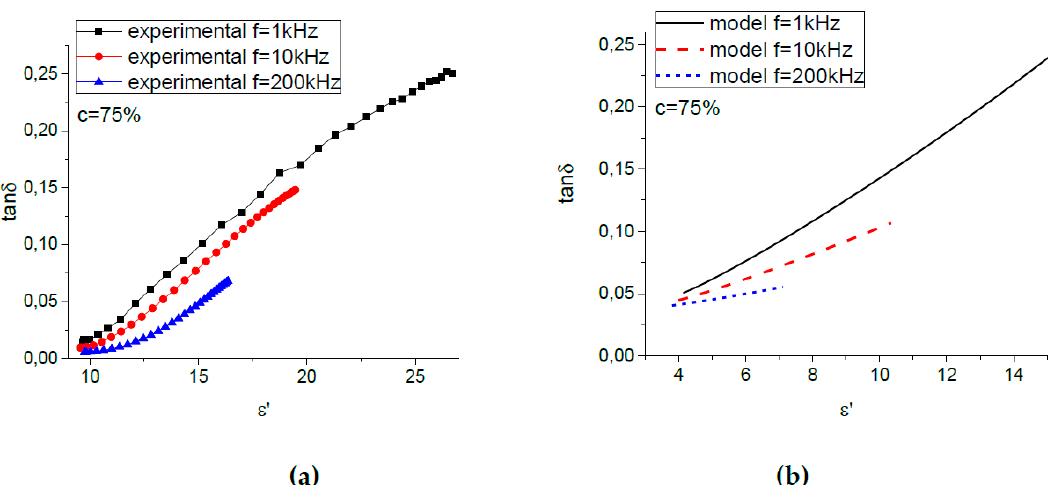
Figure 6. ( a ) Experimental and ( b ) model dependence of the dielectric loss tan δ on the relative Figure 6. (a) Experimental and (b) model dependence of the dielectric loss tan δ on the relative permittivity ε (cid:48) for MAE75 at various measurement permittivity ε ´ for MAE75 at various measurement frequencies.